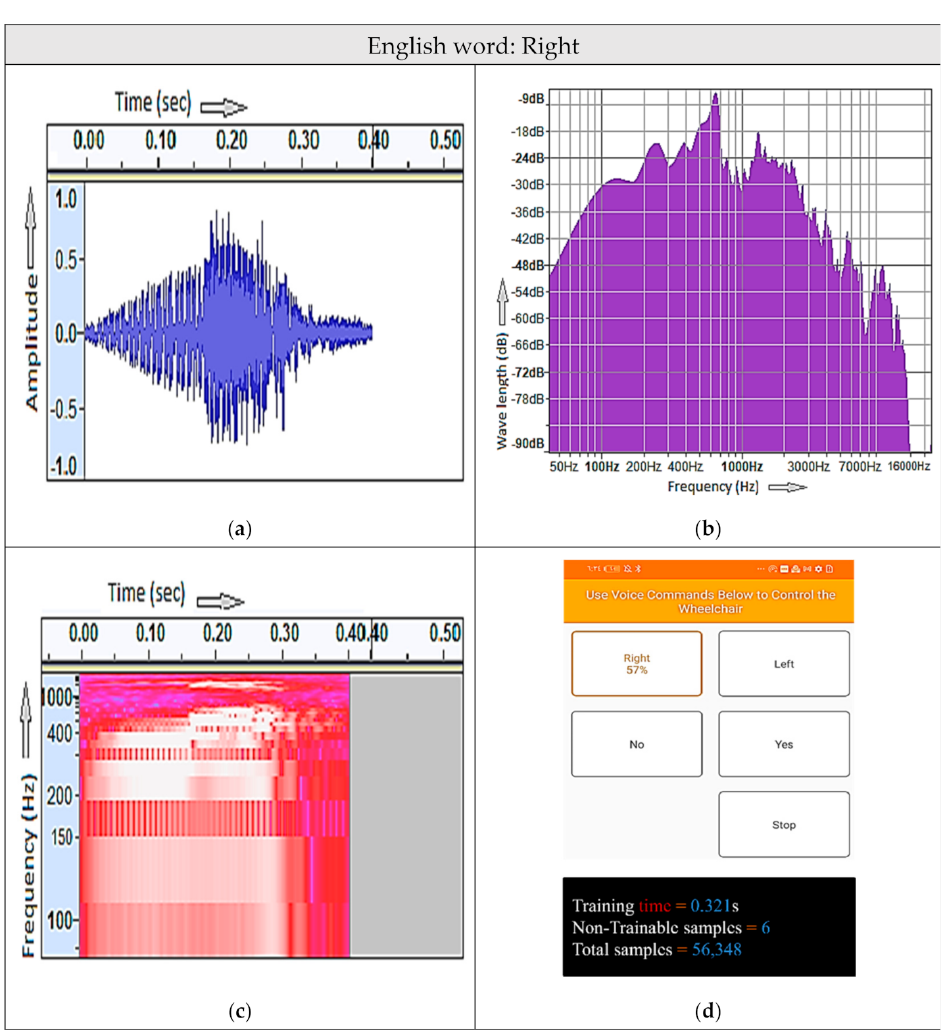
Figure 8. Recognition of the “Right” voice command. ( a ) Audio shape; training time = 0.321 s; ( b ) long- term spectrum; frequency range = 16.83 kHz; ( c ) spectrogram; ( d ) screenshot of the mobile